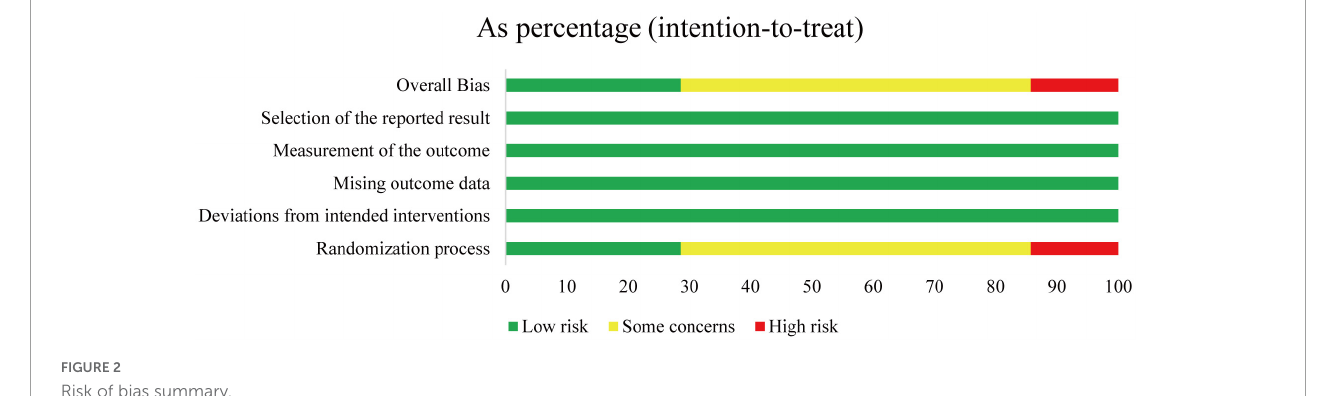
FIGURE2 Risk of bias summary.